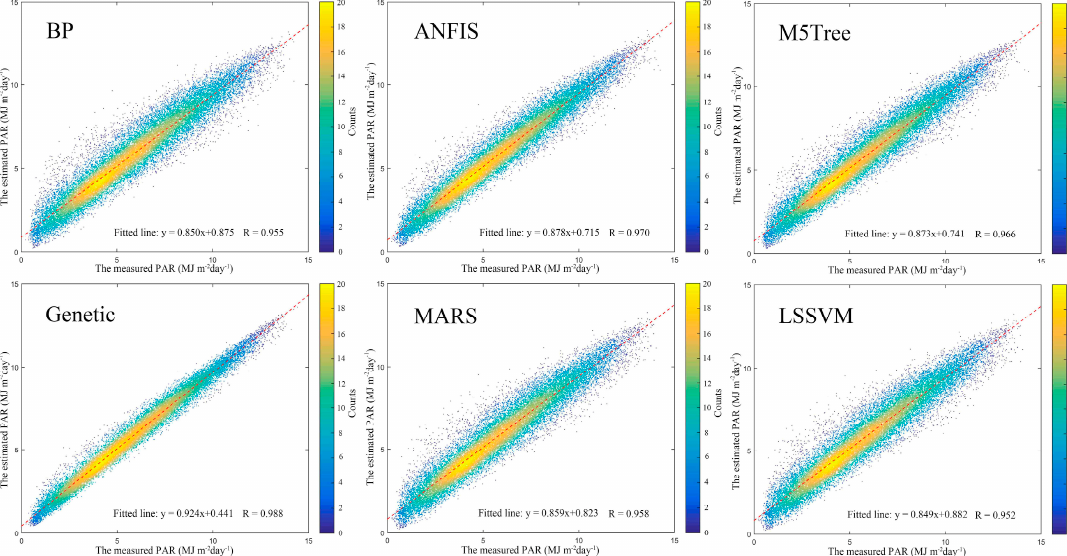
Figure 4. Validation of the estimated photosynthetically-active radiation (PAR) by the Artificial Intelligence (AI) models in the training state, at the CERN stations.